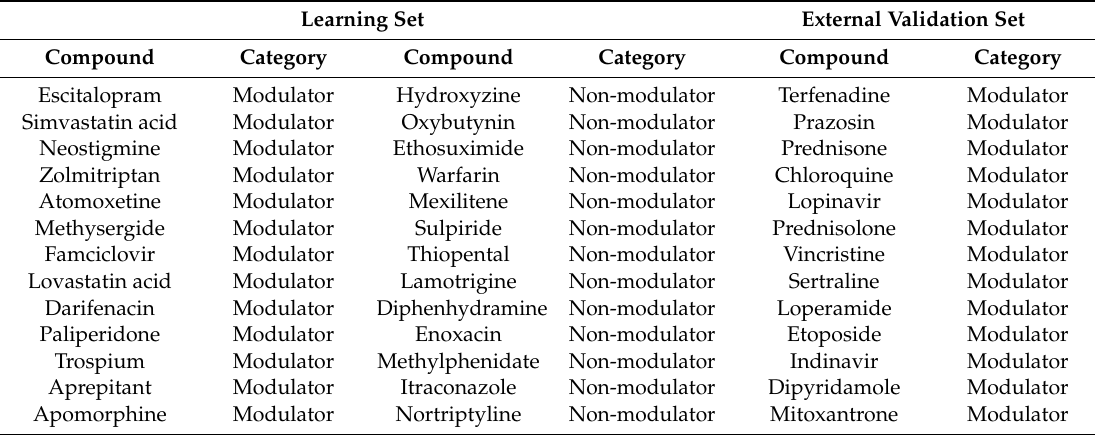
Table 1. Compounds selected for learning and external validation for the P-glycoprotein (P-gp) modulator / non-modulator prediction